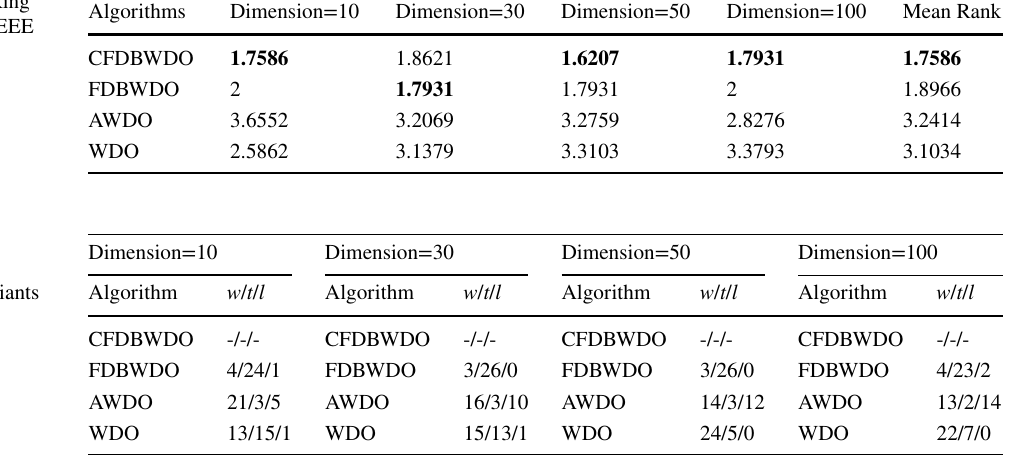
Table 4 Friedman test ranking of four WDO variants on IEEE CEC 2017